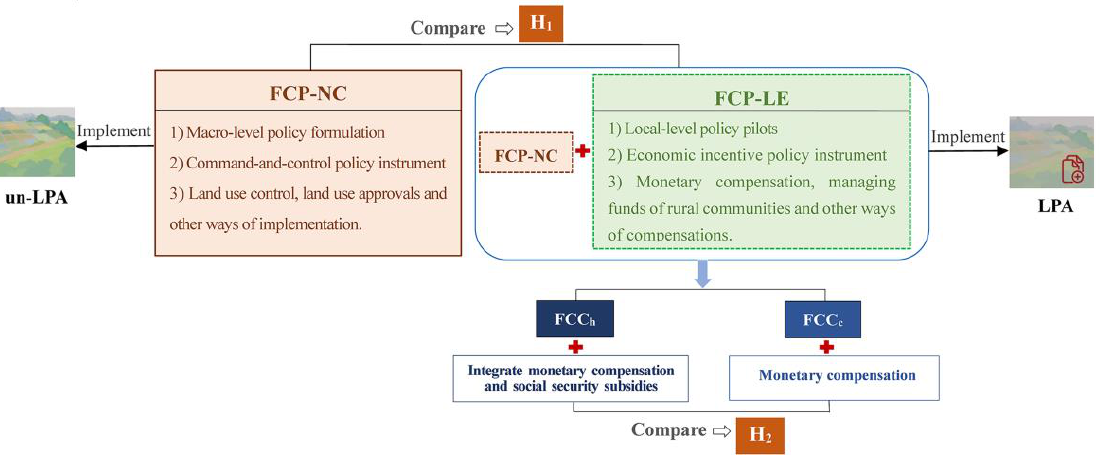
policy implementation (un-LPA), that is, areas where FCP-NC have been implemented but FCP-LE have not been implemented; (2) areas with local policy implementation (LPA), that is, areas where the implementation of FCP-LE is superimposed on the implementation of FCP-NC.